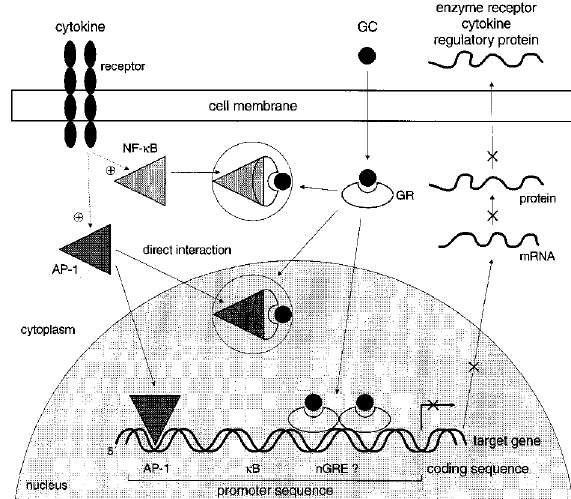
FIG. 1. Schematic representation of the cellular events after administration of glucocorticoids (adapted from Ref.